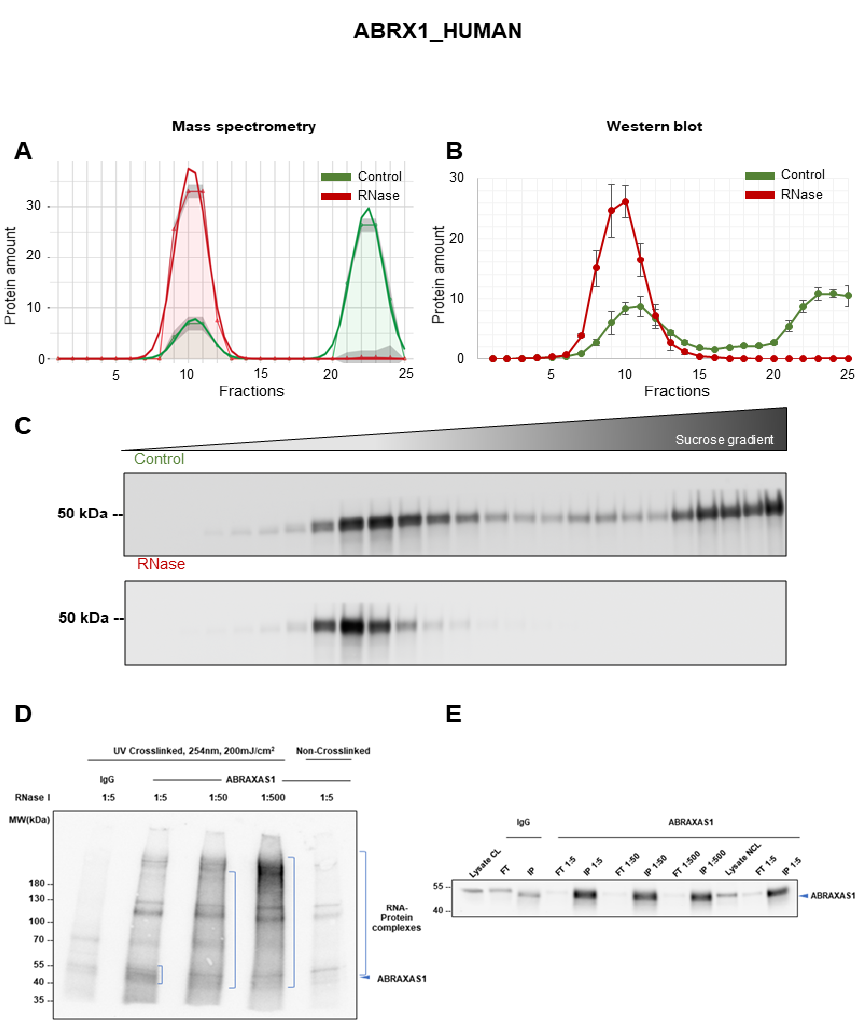
Figure 6. RNA dependence of ABRAXAS1. ( A ): Mass spectrometry analysis of the ABRAXAS1 (ABRX1_HUMAN) protein across the 25 fractions in control and RNase-treated samples (n = 3) as in Figure 4A. ( B ): Graph representing the quantitative analysis of ABRAXAS1 Western blots indicated by the mean of all three replicates and SEM. The protein amount was normalized to 100. ( C ): Western blot showing the protein distribution of ABRAXAS1 (47 kDa) across 25 fractions. ( D ): Au- toradiography showing the direct RNA binding of ABRAXAS1 by iCLIP2 indicated by shifting of the radioactive signal toward higher molecular weights with decreasing RNase I concentrations (n = 3). ( E ): Western blot verifying immunoprecipitation of ABRAXAS1 (n = 3). Original blots see File